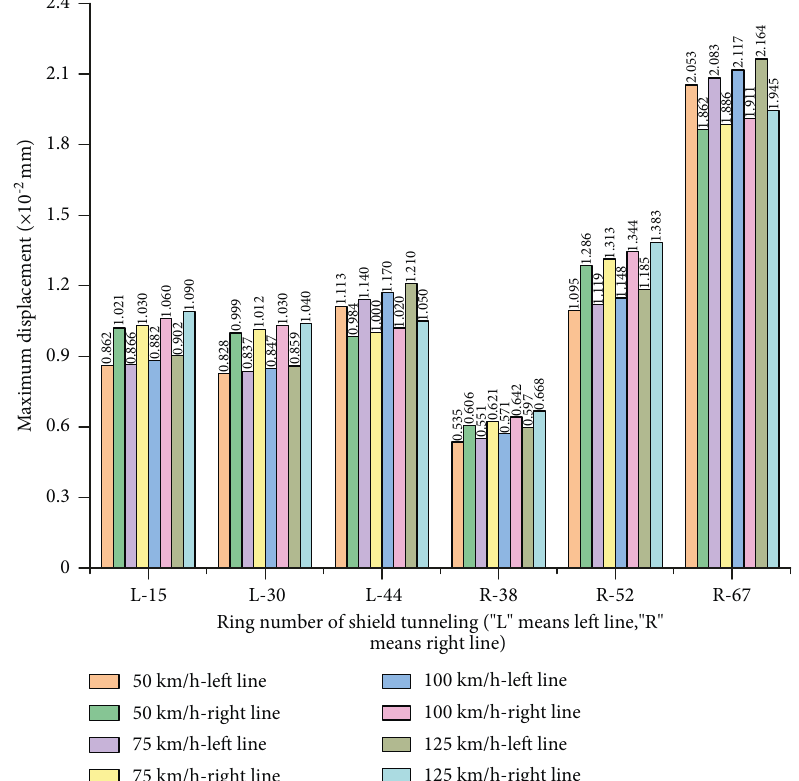
Figure 13: The maximum value of the peak displacement of the observation points on the track beds of the existing